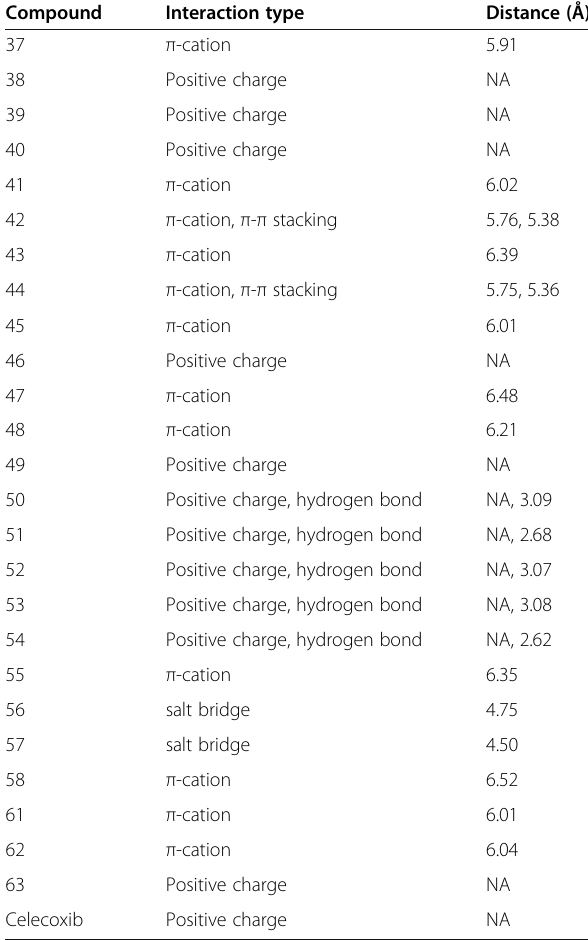
Table 3 The interactions of sydnones 37 – 58 and 61 – 63 and celecoxib with Arg513 of COX-2 binding